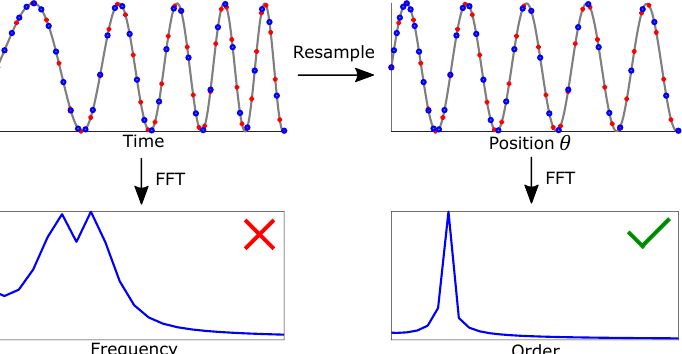
Figure 2. Visualising the benefit of the resampling process from time- to θ